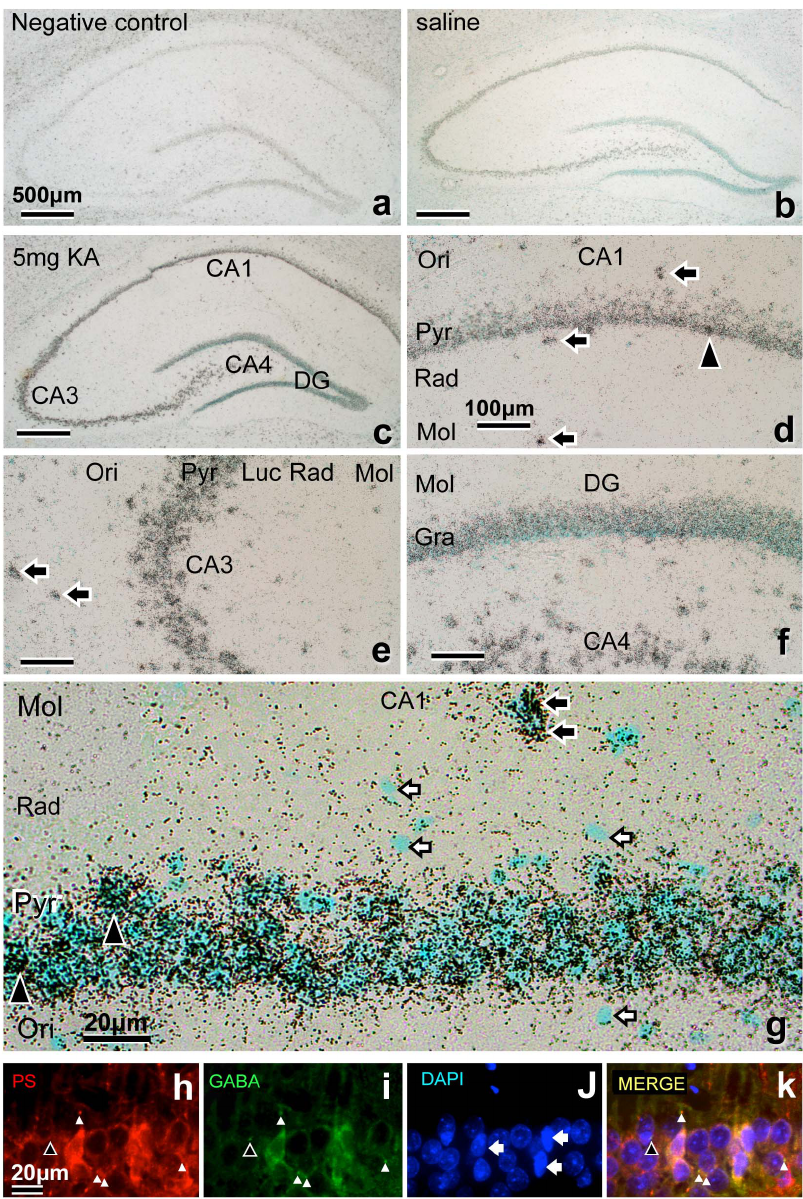
Figure 4. a–g: In situ hybridization of the hippocampus showing PS mRNA expression. The hybridization signals are shown as tiny black dots, and the nuclei were stained bluish green with methyl green. The section stained with the sense probe showed only faint hybridization signals (a: negative control). Compared with normal controls (saline injection) (b), the antisense probe signals in all hippocampal Pyr or granular (Gra) layers were significantly more intense 3 days after KA injection (c–g). Closed arrows indicate the intense interneurons in the extra-Pyr layer (d, e, g), and closed arrowheads indicate the interneurons in the intra-Pyr layer (g) with slender nuclei. Open arrows indicate smaller glial nuclei (g). h–k : Double immunofluorescence light micrographs of the rat hippocampal CA1 region 3 days after KA injection stained with anti-PS and anti-GABA. PS are stained with anti-PS (h: red), GABA with anti-GABA (i: green), nuclei are stained with DAPI (j: blue), and merged images are shown in (k). White arrowheads indicate double-stained terminals, and the black arrowhead indicates single-stained GABA terminals. Arrows indicate slender nuclei of GABA neurons. Bars 5 500 m m (a–c), 100 m m (d–f), and 20 m m (g–k).